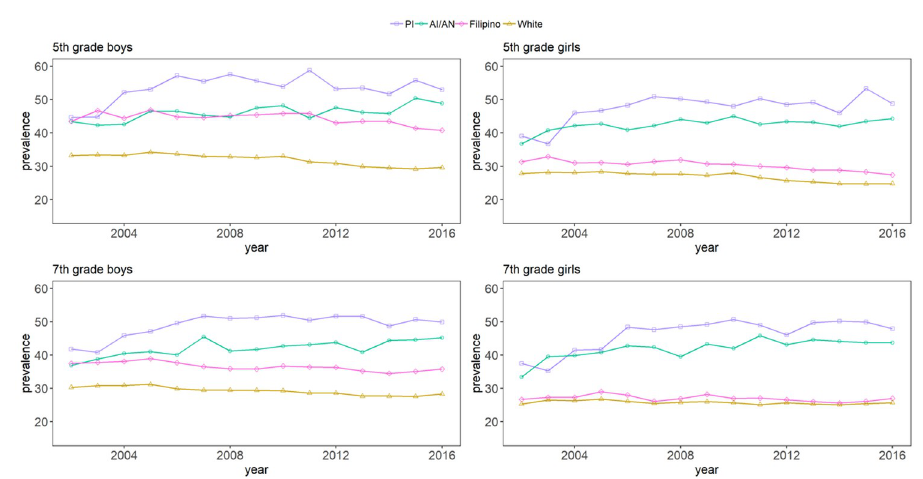
Fig 1. Observed overweight/obesity prevalence by grade, sex, and race/ethnicity. AI/AN, American Indian/Alaska Native; PI, Pacific Islander.